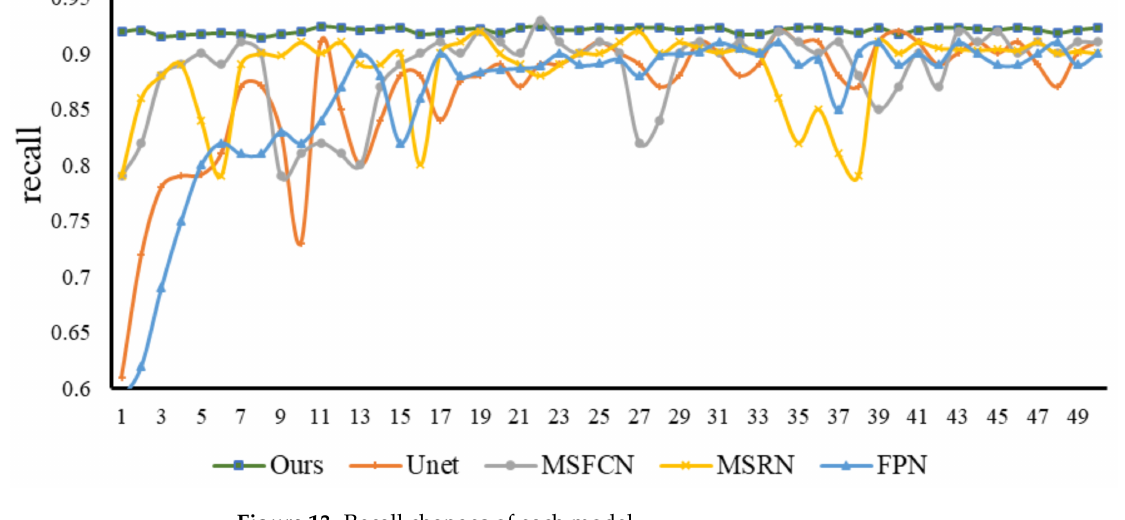
Figure 13. Recall changes of each